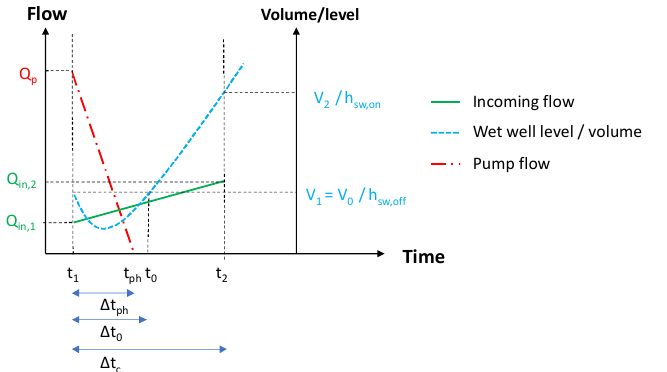
Figure 5. Calculation of phase-out time.